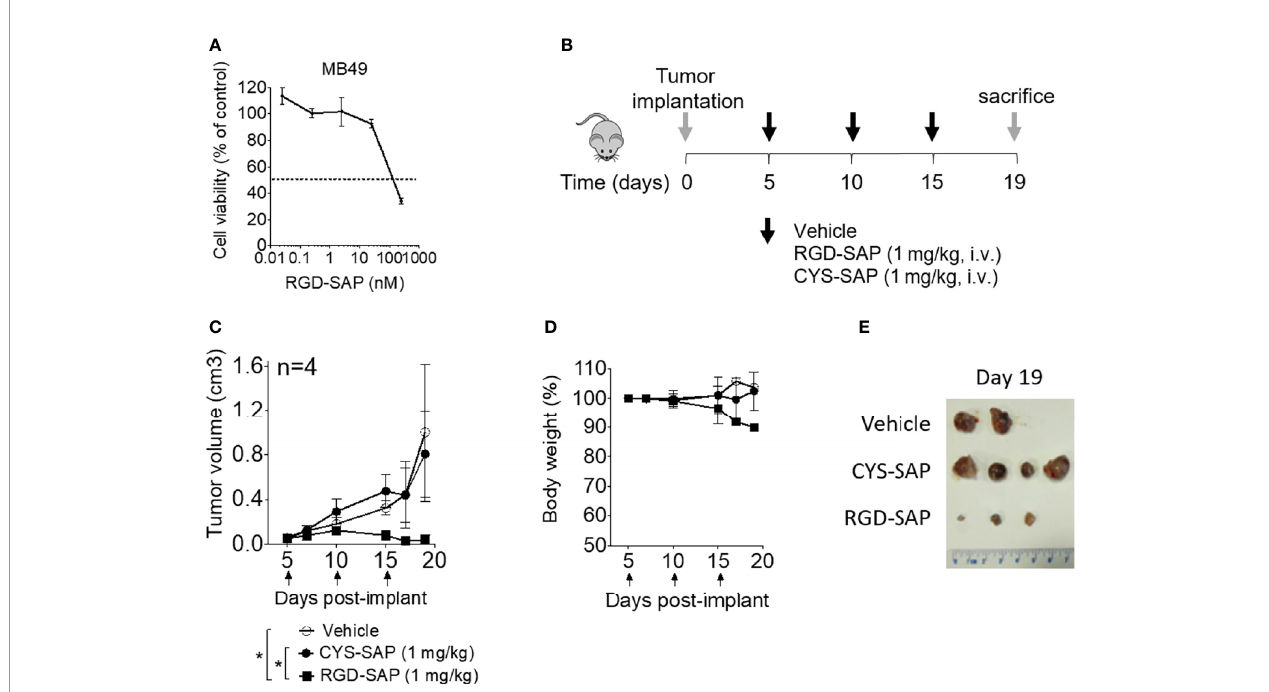
FIGURE 4 | Effects of RGD-SAP and CYS-SAP on tumor growth in a subcutaneous syngeneic bladder cancer mouse model. (A) Effect of RGD-SAP on MB49 murine bladder cancer cell line viability as measured by MTT assay. (B) Schematic representation of the experimental design and treatment schedule. MB49 cells were subcutaneously implanted in 7-week-old C57BL/6 WT female mice. Tumor bearing-mice were treated i.v. with the indicated doses of CYS-SAP or RGD-SAP or vehicle every 5 days after tumor implantation (arrows). (C) Effect of 1 mg/kg dose of CYS-SAP or RGD-SAP on MB49 bladder cancer growth. Tumor volumes (mean ± SD, n=4 mice/group) are shown. *p < 0.05, by one-way ANOVA test. (D) Effect of treatments on the animal body weight change. Animal weights are reported as percent of starting body weight (mean ± SD of 4 animals per group). (E) A representative image of MB49 subcutaneous tumors explanted from mice that survived to the end of the experiment (day 19): (vehicle (n=2), 2 mice were sacri fi ced at day 16 due to tumor ulceration; RGD-SAP (n=4), 1 tumor